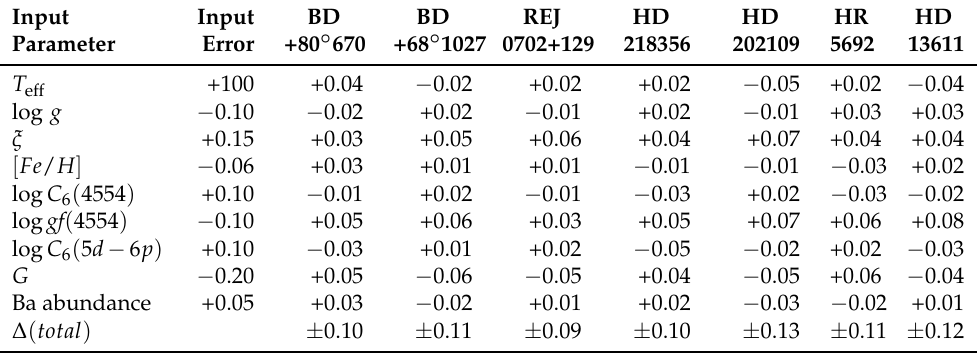
Table 4. The effect on the values of f odd,Ba due to the uncertainties of atomic data and stellar